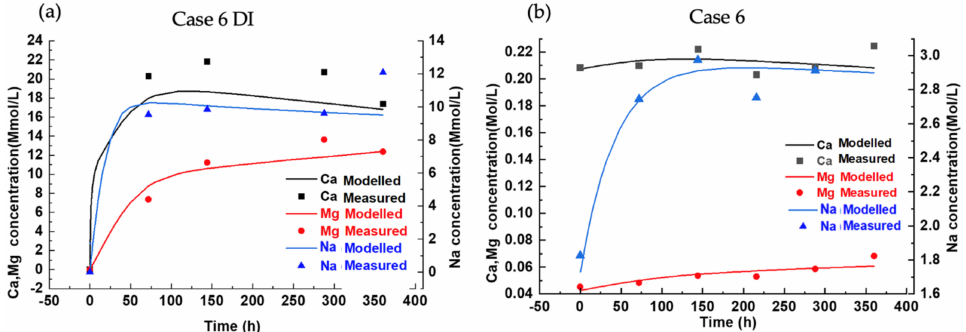
Figure 9. Fittings of the experimental and simulation results for the major ion concentrations: ( a ) Case 6 DI; ( b ) Case 6.